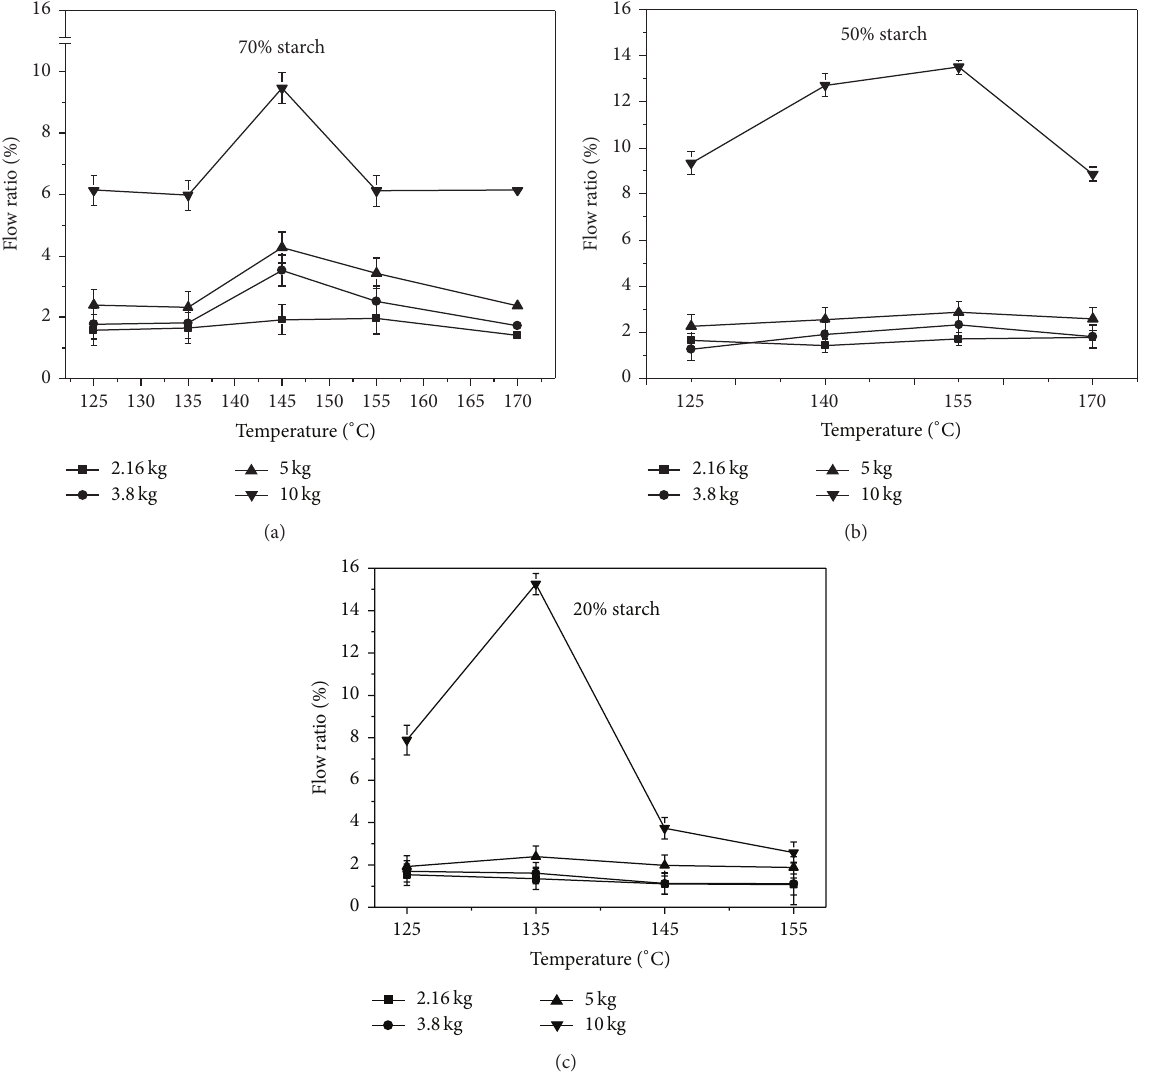
Figure 5: Flow ratio versus temperature, load, and composition for the blends with (a) 70%, (b) 50%, and (c) 20% starch (line only for eliminating the confusions regarding the symbols’ affiliation to a certain